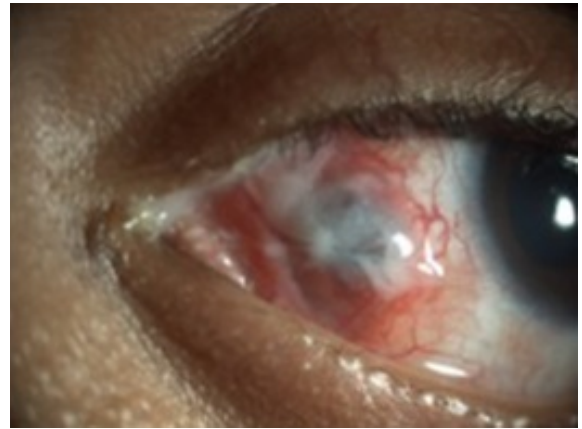
Figure 3: Resolving subconjunctival abscess with scleral necrosis and necrosed medial